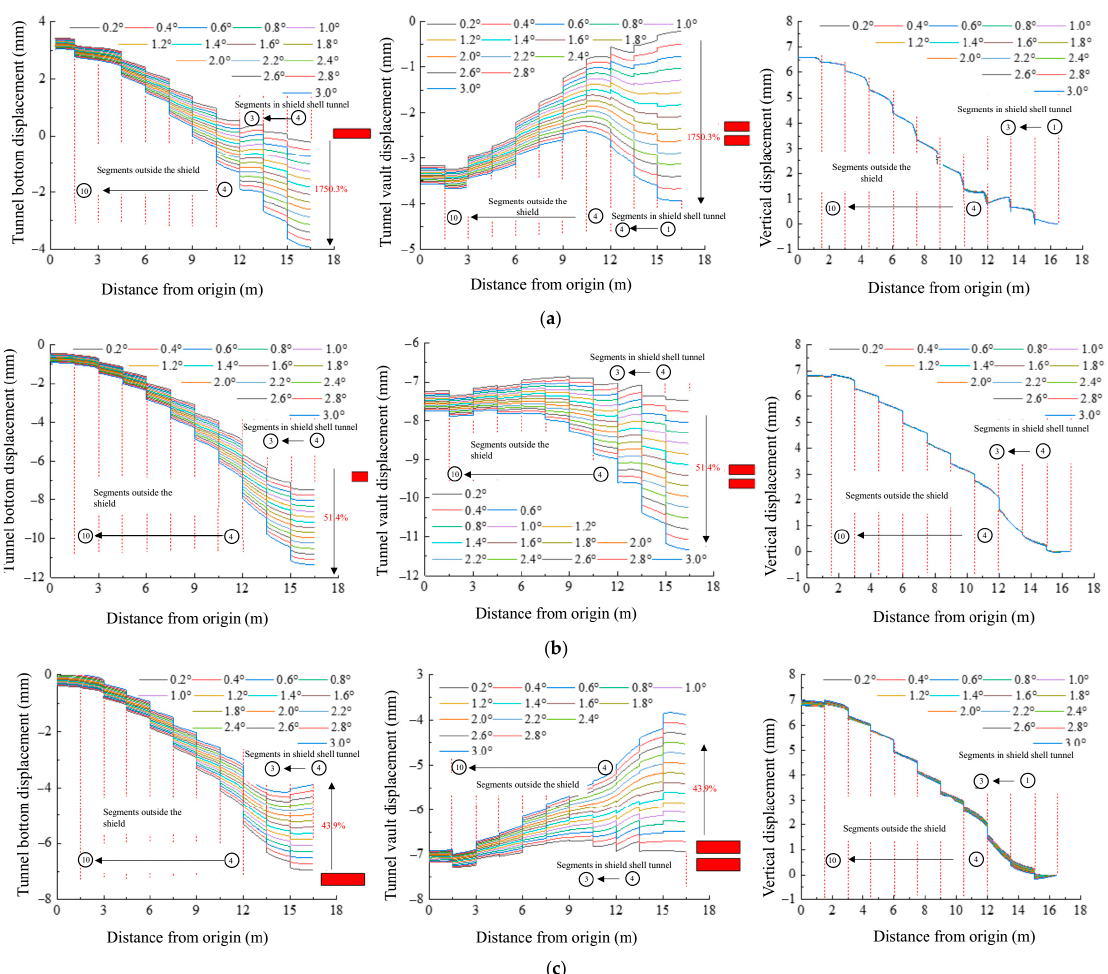
Figure 14. Tunnel displacement and transverse deformation. ( a ) Upward direction of shield machine. ( b ) Downward direction of shield machine. ( c ) Left direction of shield machine. By comparing the amount of staggered platform between the four positions of the tunnel vault, arch bottom, and both sides of the arch waist, it is finally determined that the maximum amount of staggered abutment is found between the arch bottom ring and the arch bottom ring. Compared with the adjacent pipe rings, the amount of staggering between the third and fourth rings is the largest. It can be seen from Figure 15 that when the shield machine goes up, the maximum amount of staggering between rings increases linearly with the increase of jack thrust deflection angle, and the rising slope is 0.127 mm/°. When the shield machine goes down and left, the maximum amount of stagger- ing between rings decreases linearly with the increase of Jack thrust deflection angle, and the decline rate is − 0.105 mm/° and − 0.005 mm/°.